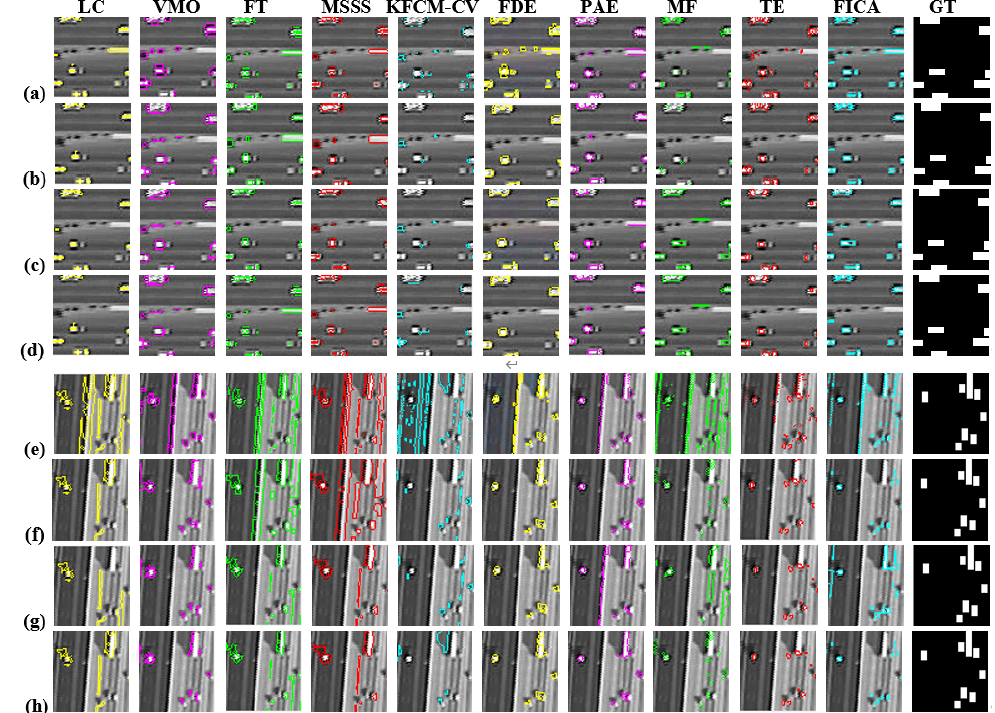
Figure 4. Visual comparison of ten algorithms without/with post ‐ processing. Detections are shown as colored boundaries. Row ( a ) shows initial detection, ( b – d ) show results using the three post ‐ processing schemes voted from Table 3 for Tucson dataset, respectively. Similar results are shown in row ( e ) and rows ( f – h ) for Phoenix dataset. GT vehicles are displayed in the last column.